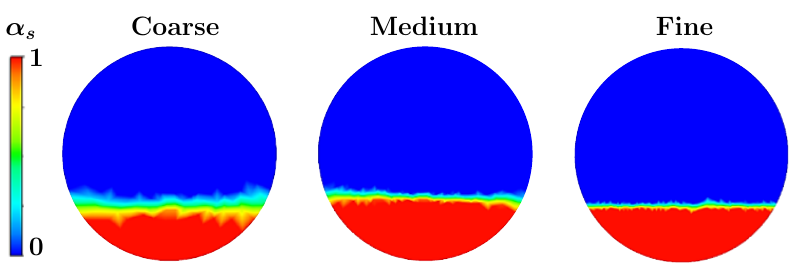
Figure 4. Radial cross section at the initial time for the different